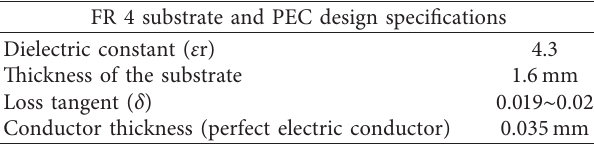
Table 1: Substrate and PEC design specification of the proposed RFID reader antenna.